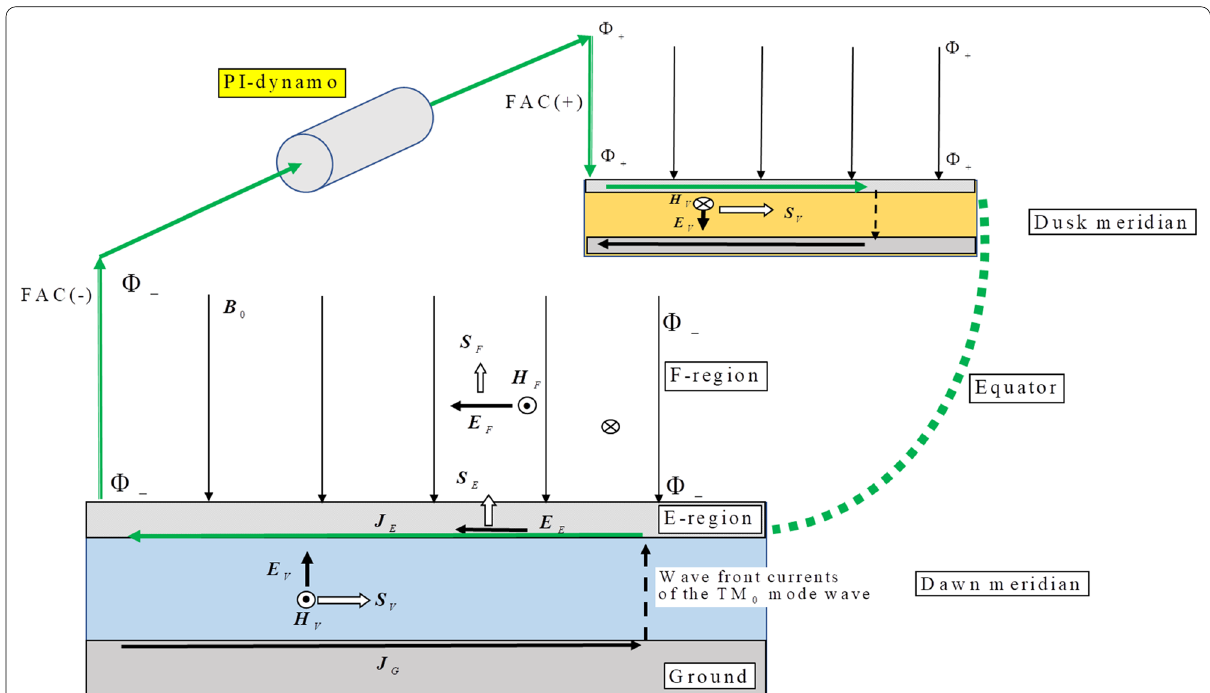
) on the duskside and negative +